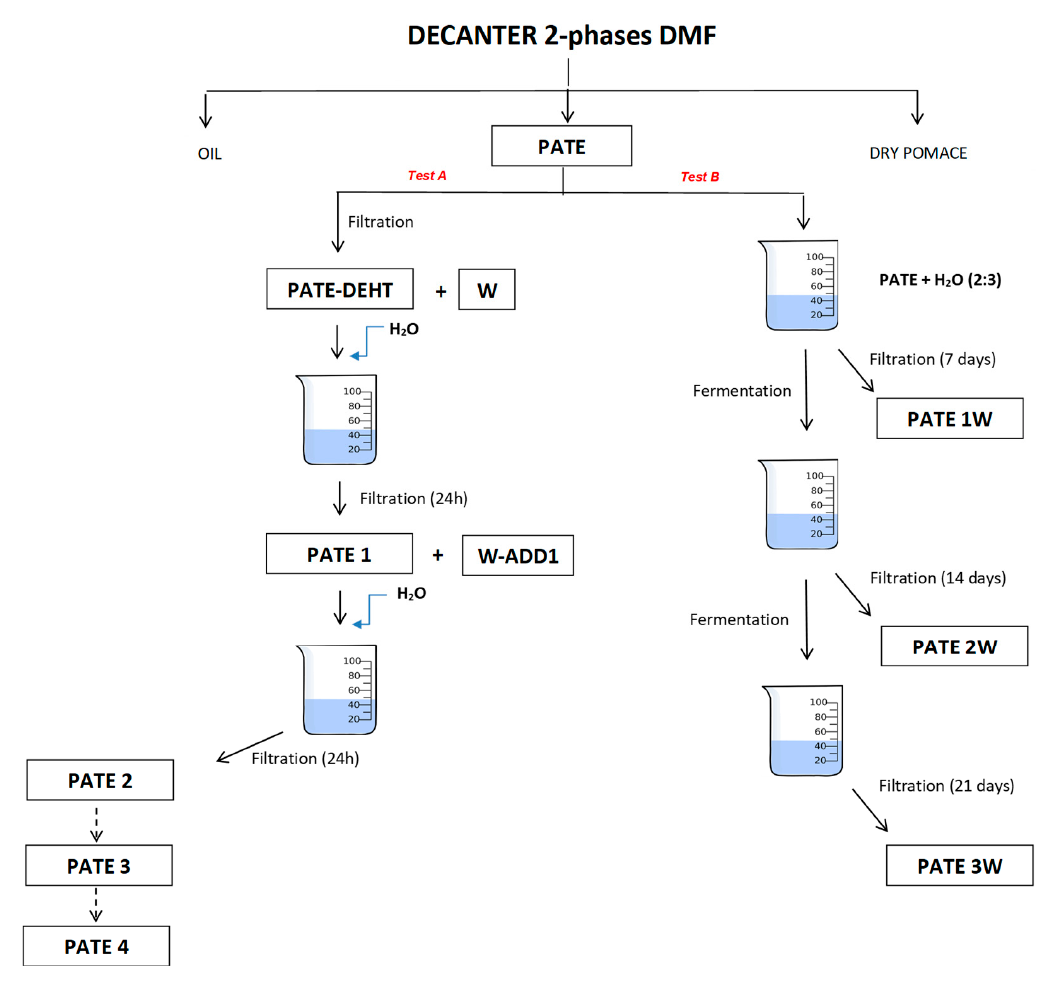
Figure 7. Experimental trial.